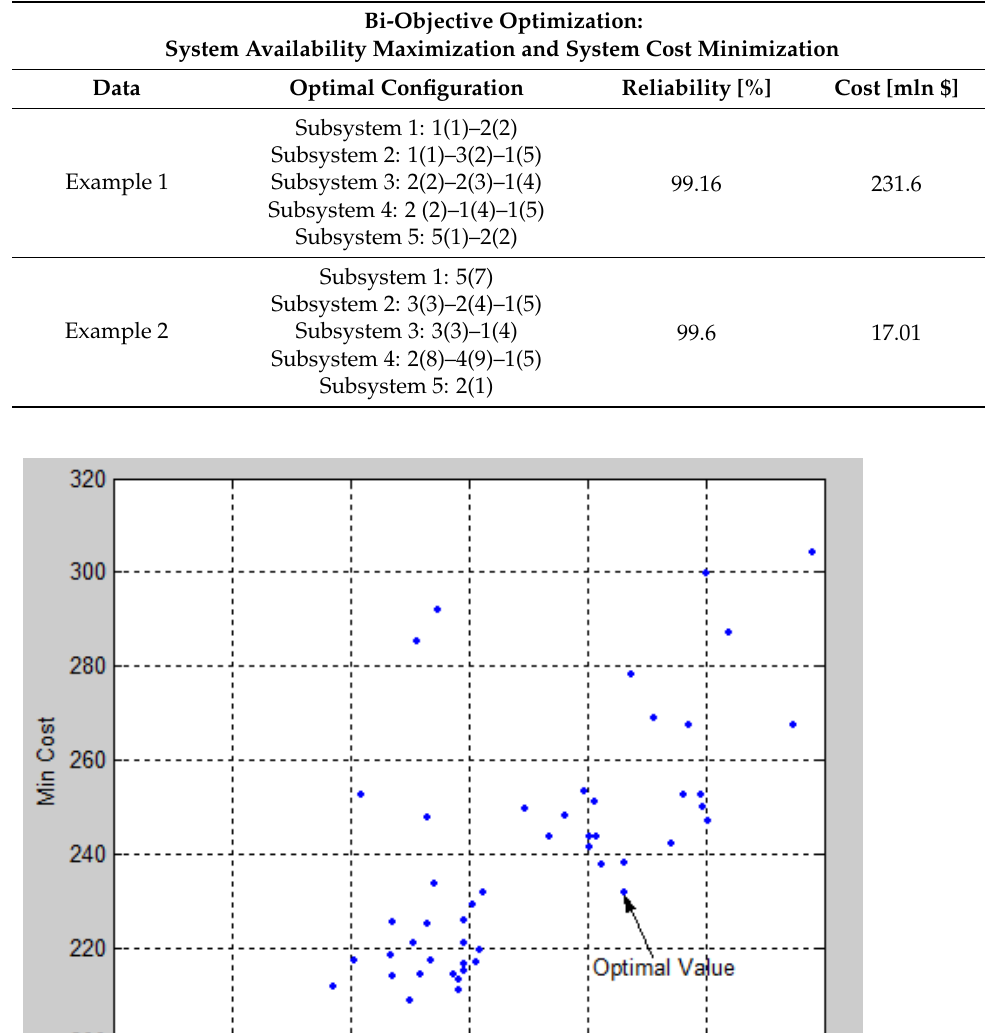
Figure 4. Pareto front of Example 2.